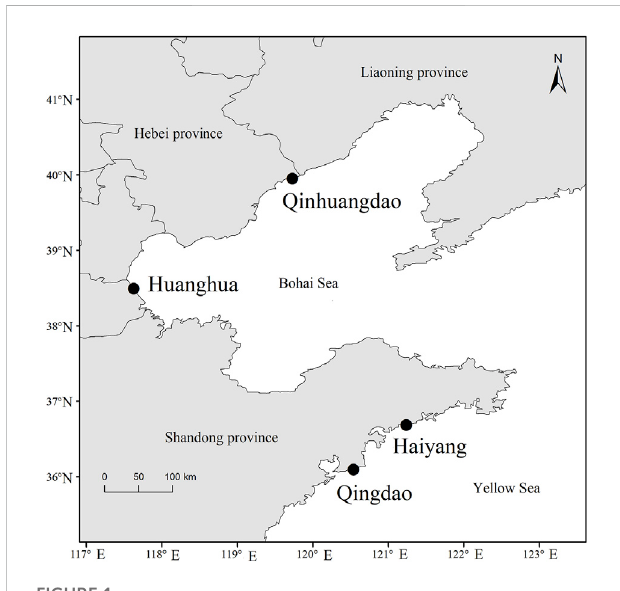
FIGURE 1 Distribution of Fenneropenaeus chinensis sampling locations.